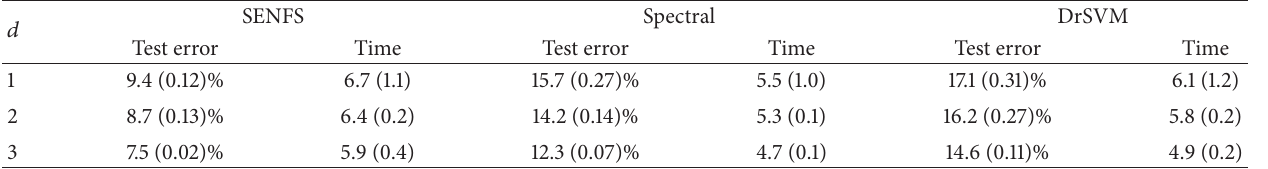
Table 2: Comparisons of test errors, computational time needed, and their standard errors (in parenthesis). 𝑑